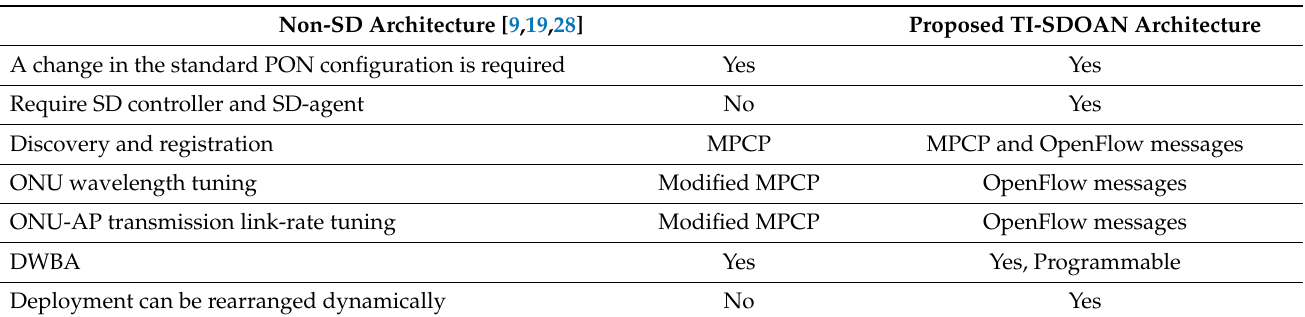
Table 1. Comparison of Tactile Internet-software-defined optical access networking (TI-SDOANs) and non- software-defined networking (SDN) architecture and operations in time and wavelength division multiplexing